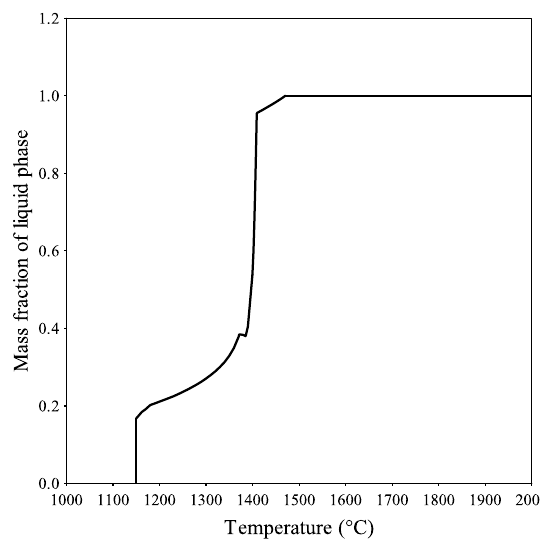
Figure 2. The mass fraction of liquid phase in the slags used in Trials 1 and 2 for a temperature span between 1000 and 2000 °C. The calculations were done by assuming an open system with an oxygen potential of 0.3.